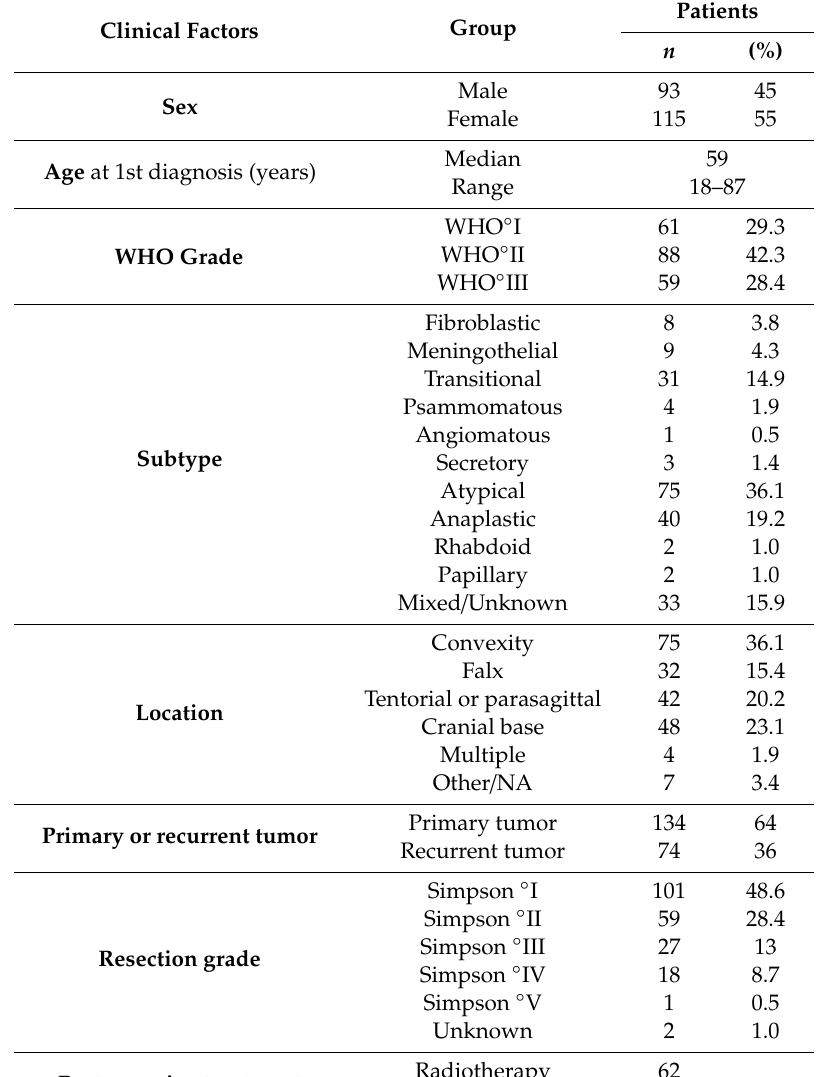
Table 1. Clinical characteristics of the study sample used to validate the mRNA expression of kinesin family members ( n =